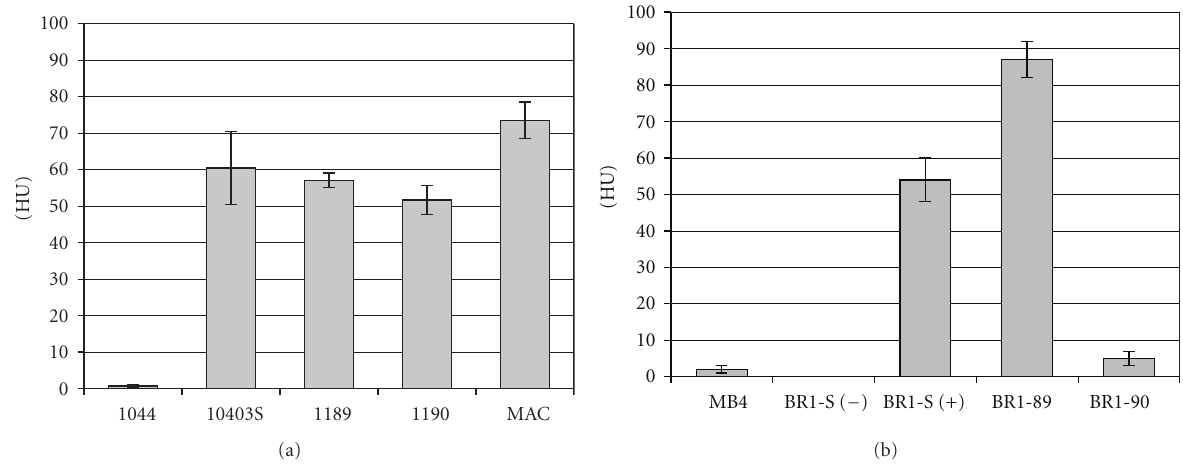
Figure 1: Hemolytic activity of L. monocytogenes (a) and B. subtilis (b) strains. Spectrophotometric measurements of the hemolytic activity of the bacterial supernatants of Listeria monocytogenes (a) and Bacillus subtilis (b) strains tested on sheep erythrocytes (SRBC). The negative control was 20 μ L of BHI medium, 2% of final sample volume, exactly as in the tested supernatants. Hemolysis of the negative control was defined as zero hemolytic units (HU). The positive control absorbance was set to 100 HU, defined as the hemolysis caused by 20 μ L of 0.5% SDS (0.01% final concentration). BR1-S ( − ) is B. subtilis strain grown without IPTG, BR1-S (+) the same strain induced with IPTG. Hemolytic activity of the bacterial strains was calculated according to the absorbance of controls. The average of three independent experiments ( n = 3) is indicated with bars showing standard deviation. Table 2: Survival of Jurkat cells treated with di ff erent concentrations of L. monocytogenes strain supernatants. Strain